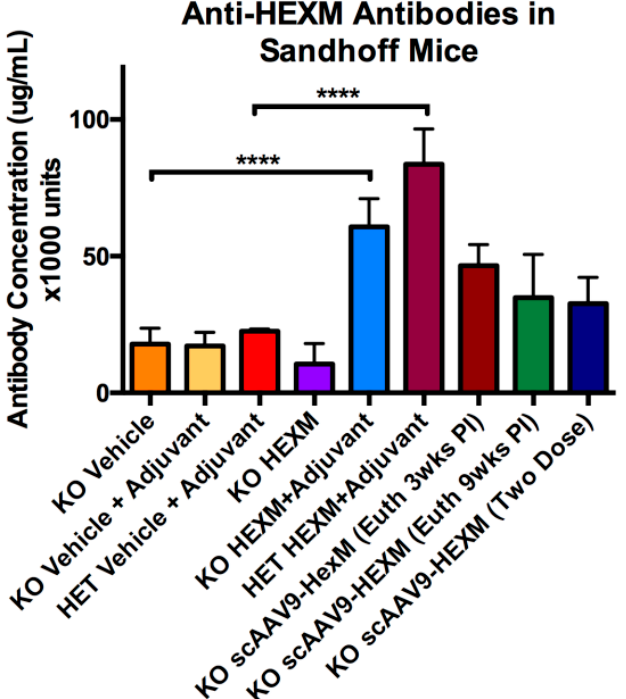
Figure 5. Anti ‐ HexM antibody levels in sera of SD mice. HexM ‐ specific B cell response in SD KO and Het mice at the endpoint (3 weeks post injection 1 or 6 weeks post injection 2). High levels of anti ‐ HexM antibodies were observed in both Het and KO mice given HexM purified protein with adjuvant. Vehicle ‐ injected mice showed low levels of anti ‐ HexM antibodies. Euth = euthanized, wks = weeks, PI = post injection, error bars = SEM, **** = p < 0001.